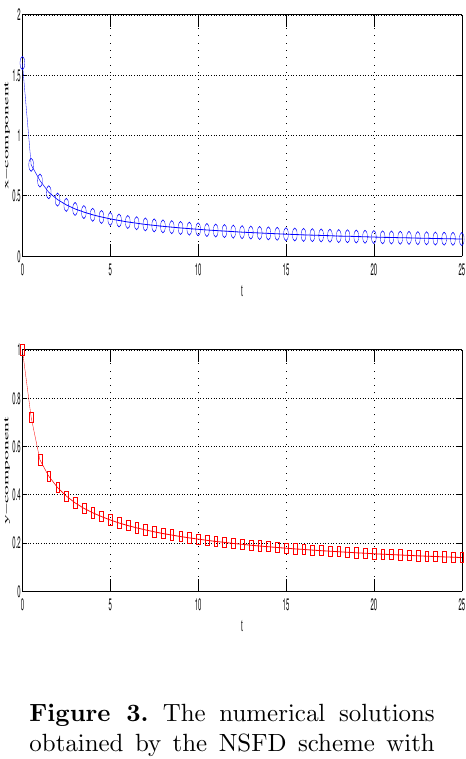
Figure 3. The numerical solutions obtained by the NSFD scheme with h = 0 . 5 after 50 iterations in Exam- ple 3.